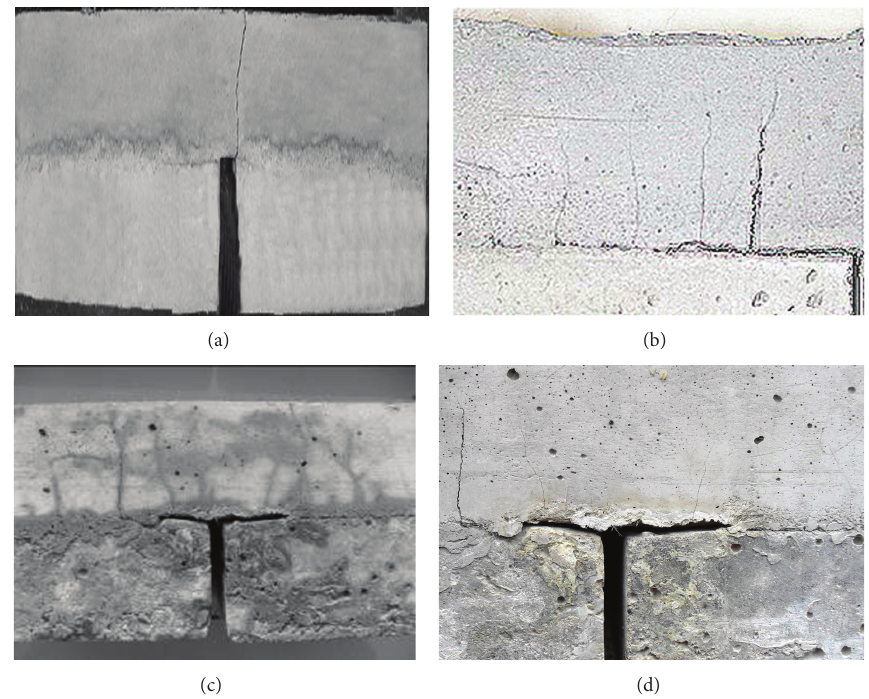
Figure 5: Damage pattern of concrete and ECC repair overlay system. (a) Concrete overlay system, (b) PVA ECC, (c) PP ECC sandblast and moisture, and (d) PP ECC sandblast and